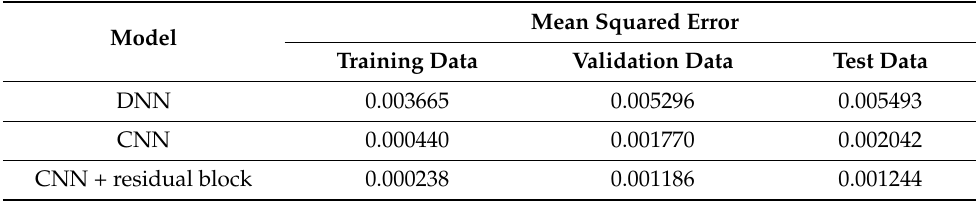
Table 3. MSE loss comparison for each dataset according to the deep learning